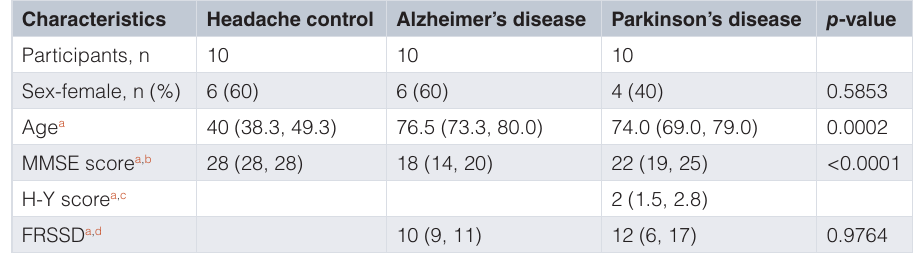
Table 1. Patient cohort